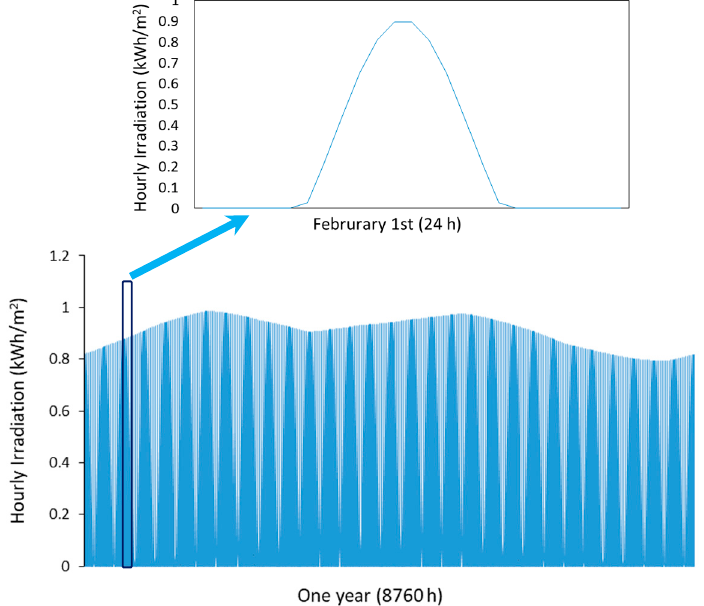
Figure 3. Hourly solar irradiation (in an average year) and detail for a specific day at the grid location .